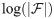
Food spread and source blending across the colony.(a) The amount of food held by each non-forager ant a at the end of the experiment, P(a), partitioned into conditional probabilities P(f|A = a) by forager origin (f = 268, green, f = 171 purple, f = 180 blue, f = 421 orange, f = 207 pink; vertically ordered by amounts received). Ants are ordered by the amount of food in their crop, and the dashed line is an exponential fit y = ae−bx,a = 0.061 ± 0.002, b = 0.062 ± 0.003, R2 = 0.96. For colonies B and C see S2 Fig. (b) The extent to which food from each forager f (color code as in panel a) was distributed among non-forager ants a: P(a|F = f). Recipient ants are ordered (per forager f) by amount received. Dashed curve is an exponential fit y = ae−bx, a = 0.095 ± 0.0013, b = 0.1 ± 0.002, R2 = 0.97. For colonies B and C see S2 Fig. (c) Mixing entropies as a function of the number of trophallactic interactions starting from the first return of a loaded forager. Entropies are normalized by log(|F|) to allow for data averaging over the three experiments. Lines are the mean over three experiments while shaded areas designate standard deviations. Depicted are the empirical entropy associated with the different proportions of food as brought in by each forager Htypes (blue), the empirical mixing entropy over all non-forager ants Hmix, (red) and the mixing entropy for hybrid simulations where randomized interaction volumes and transfer directions were simulated over the empirical interaction schedule (N = 30, shaded area depicts standard deviation of the outcomes). Discontinuities are a consequence of the variable number of interactions among the three experiments. (d) A histogram of normalized individual mixing entropies of all non-forager ants, hmixa/log(|F|), at the end of the experiments (all three experiments, N = 203 ants).